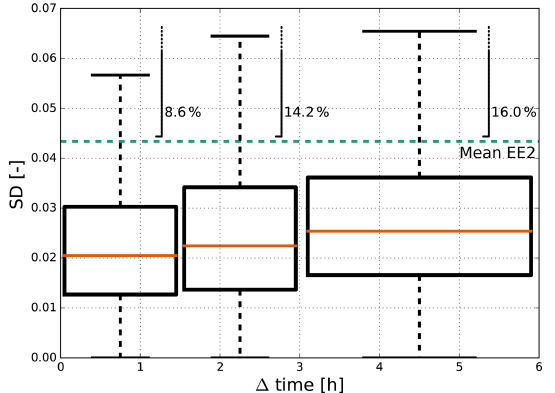
Figure 9. Temporal variation of AOD expressed as the stan- dard deviation (SD) of SEVIRI AOD between MODIS over- passes, as a function of time lag between retrievals ( (cid:49) time). The mean of the expected error limits (EE2) of MODIS [ + ( 0 . 04 + 0 . 1AOD ), − ( 0 . 02 + 0 . 1AOD ) ] is calculated from the mean SEVIRI AOD of all data points and shown as the dashed green line. A vari- ation in AOD can be considered significant if the magnitude of SD exceeds the error limits. The percentage of significant situations is denoted for each time interval.